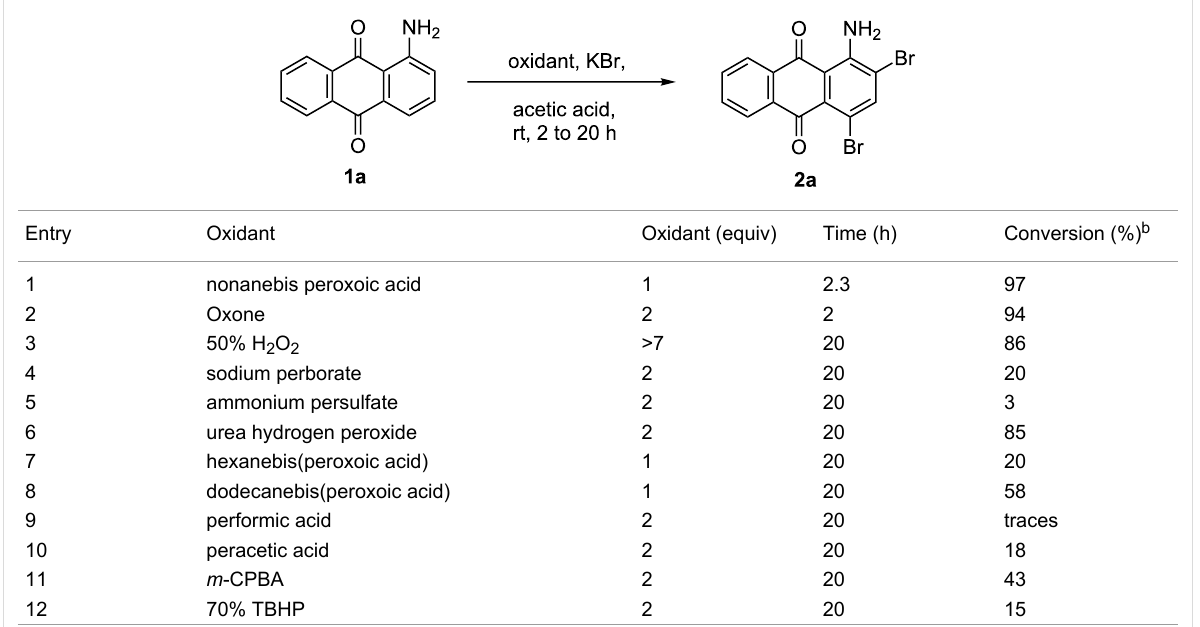
two oxidants for the bromination of some substrates listed in Table 4. The bromination of substrate 1b using Oxone as an oxidant required 14 h for complete conversion at room tempera- ture. Whereas, the substrate 1g did not show complete conver- sion in 24 h at room temperature as well as at 50–55 °C. The N-alkylated substrates such as 1i , 1j and the substrate 1k showed poor conversion (product formed in tracess) even at